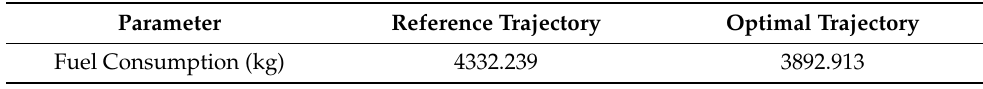
Table 3. Fuel consumption of reference and fuel optimal